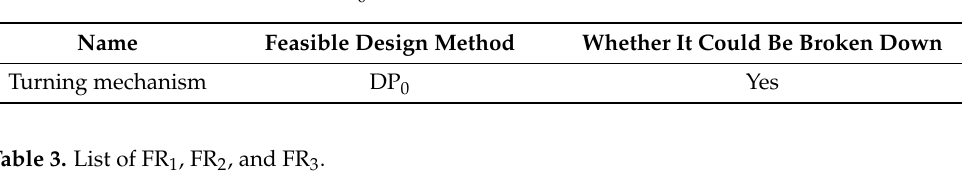
Table 2. List of terminal nodes for FR 0.